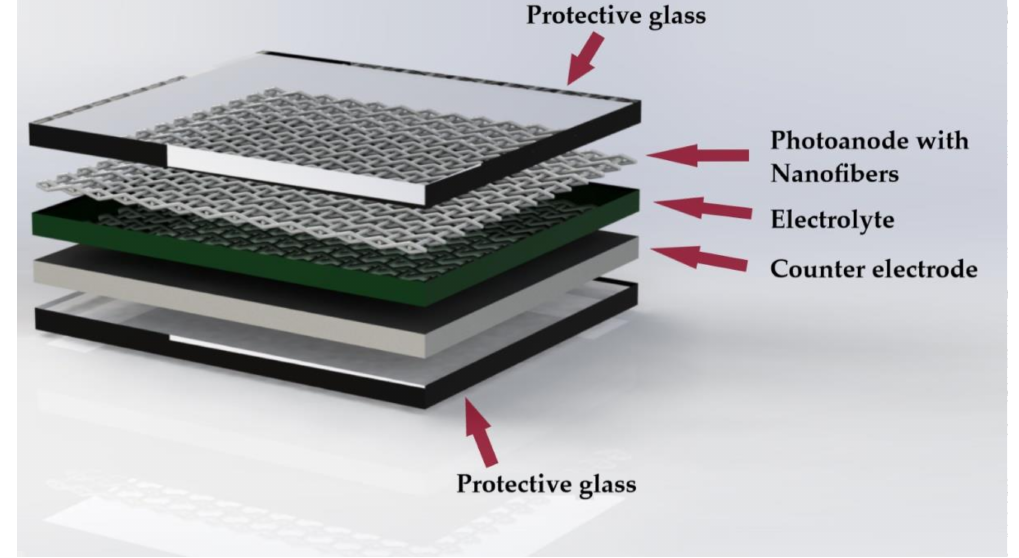
Figure 3. Photoanode with electrospun nanofibers in a